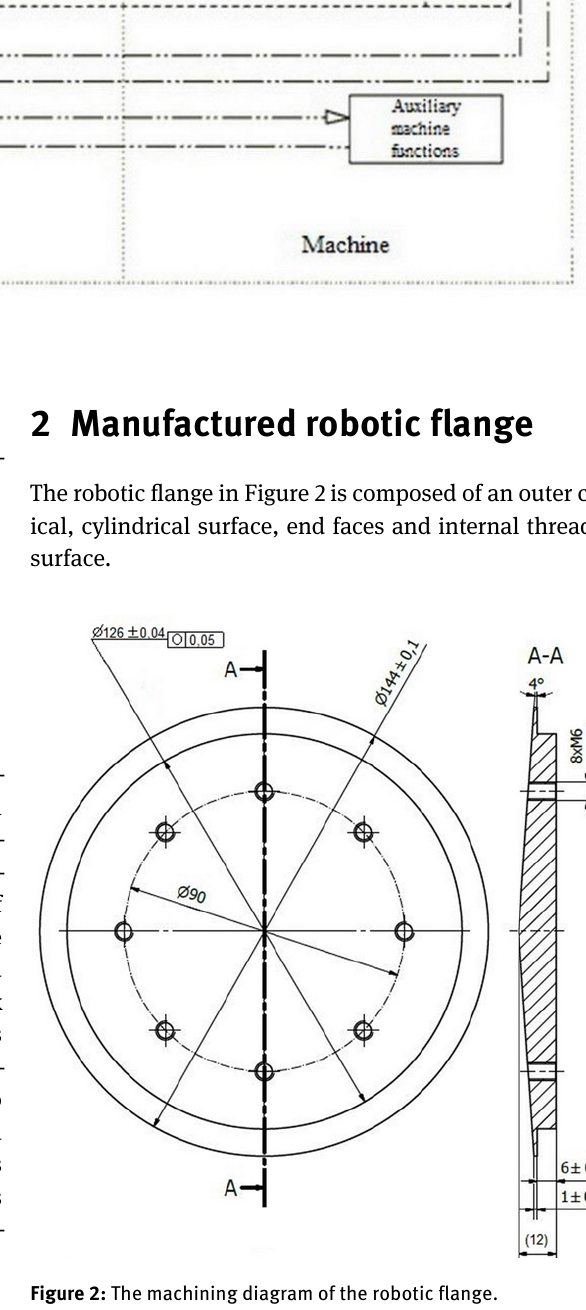
Figure 2: The machining diagram of the robotic